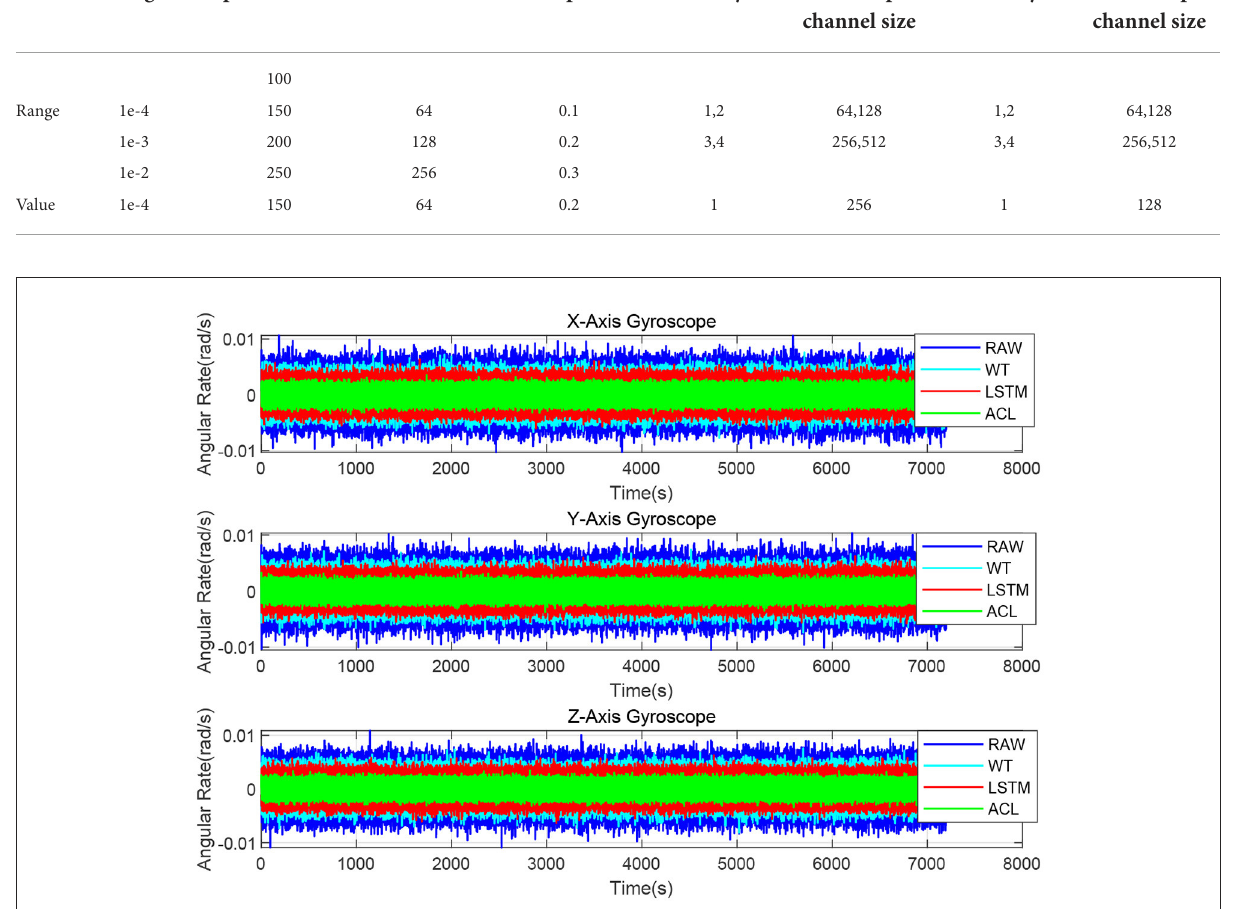
FIGURE4 The denoised and raw signals comparison for the 3-axis gyroscope of